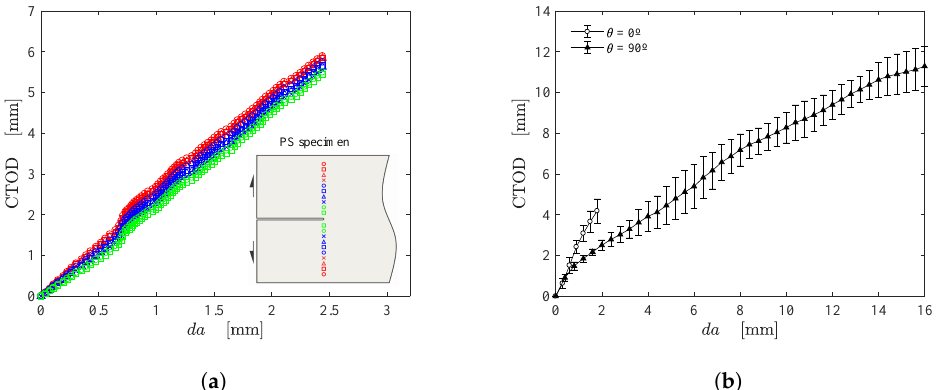
Figure 10. ( a ) CTOD estimation using different DIC calculation points and ( b ) CTOD- da curve for fiber orientations of 0 ◦ and 90 ◦ .